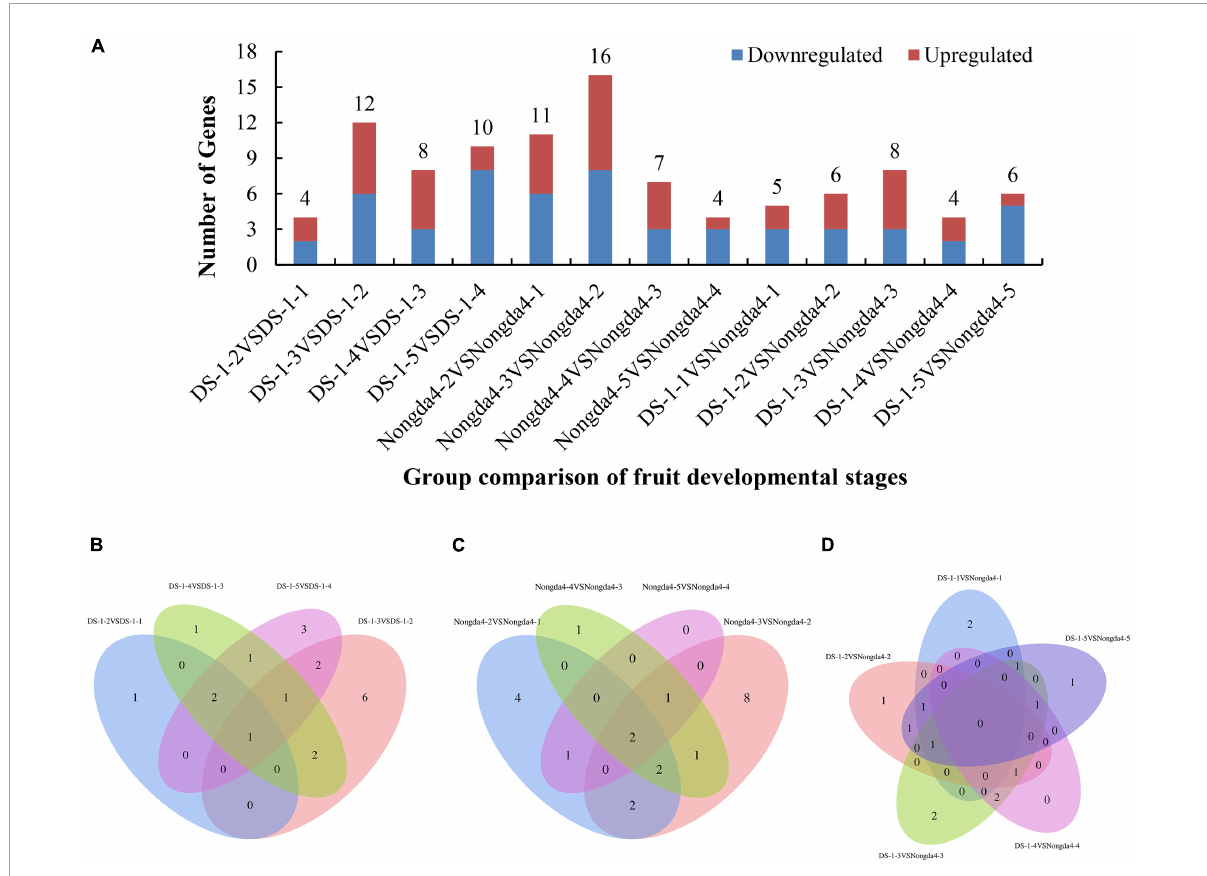
FIGURE2 The number of differentially expressed genes related to organic acid metabolism (A) , and Venn diagrams illustrating differential metabolism between different developmental stages of DS-1 (B) , different developmental stages of Nongda4 (C) , two varieties in the same developmental stage (D) . DS-1-1, DS-1-2, DS-1-3, DS-1-4, DS-1-5, Nongda4-1, Nongda4-2, Nongda4-3, Nongda4-4, and Nongda4-5 indicate DS-1 and Nongda4 fruits at S1, S2, S3, S4, and S5 developmental stages, respectively.